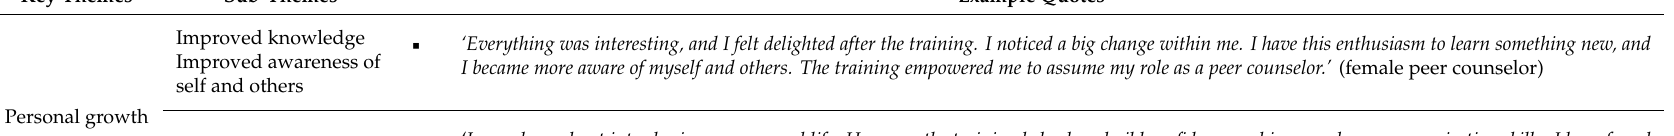
Table 6. Impact of leadership and peer counseling program on peer counselors’ well-being.